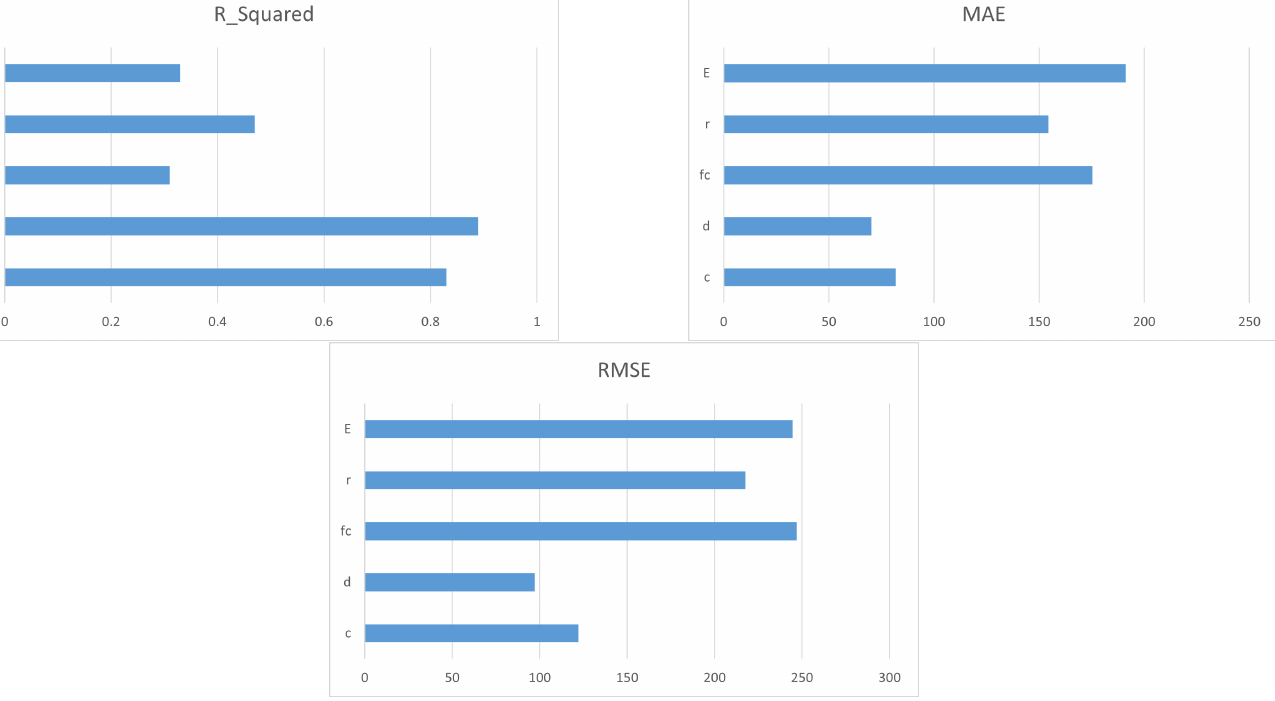
Figure 3. Importance of input variables in the boosted model reported in R 2 , MAE, and RMSE.